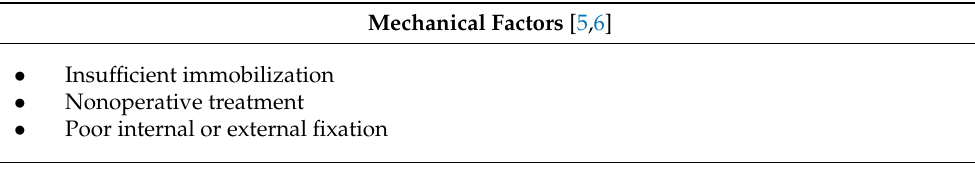
Table 1. Mechanical and biological factors.